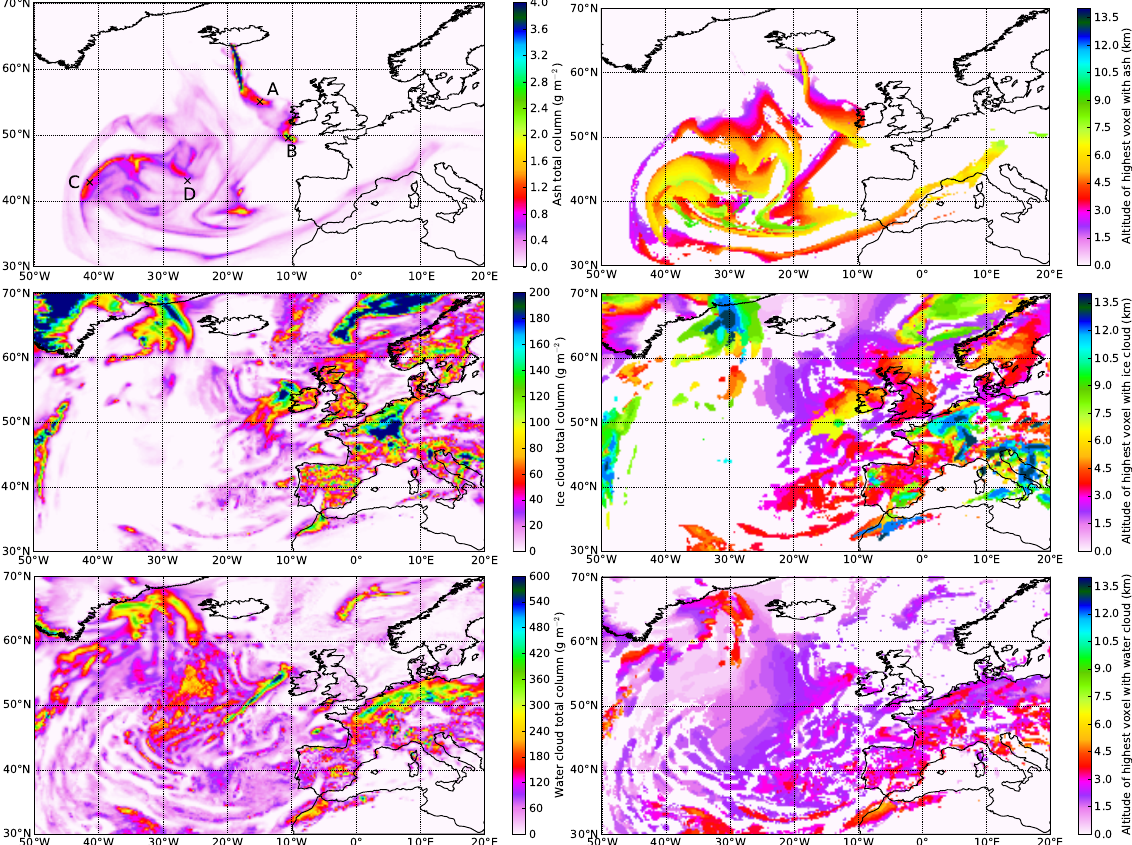
Fig. 5. Left column: the total column density of the ash as simulated by FLEXPART (top panel), ice (middle panel) and water (bottom panel) clouds from ECMWF. Right column: the altitude of the highest voxel with ash concentration above 0.1mgm − 3 (top panel), ice above 10mgm − 3 (middle panel), and water above 50mgm − 3 (bottom panel).